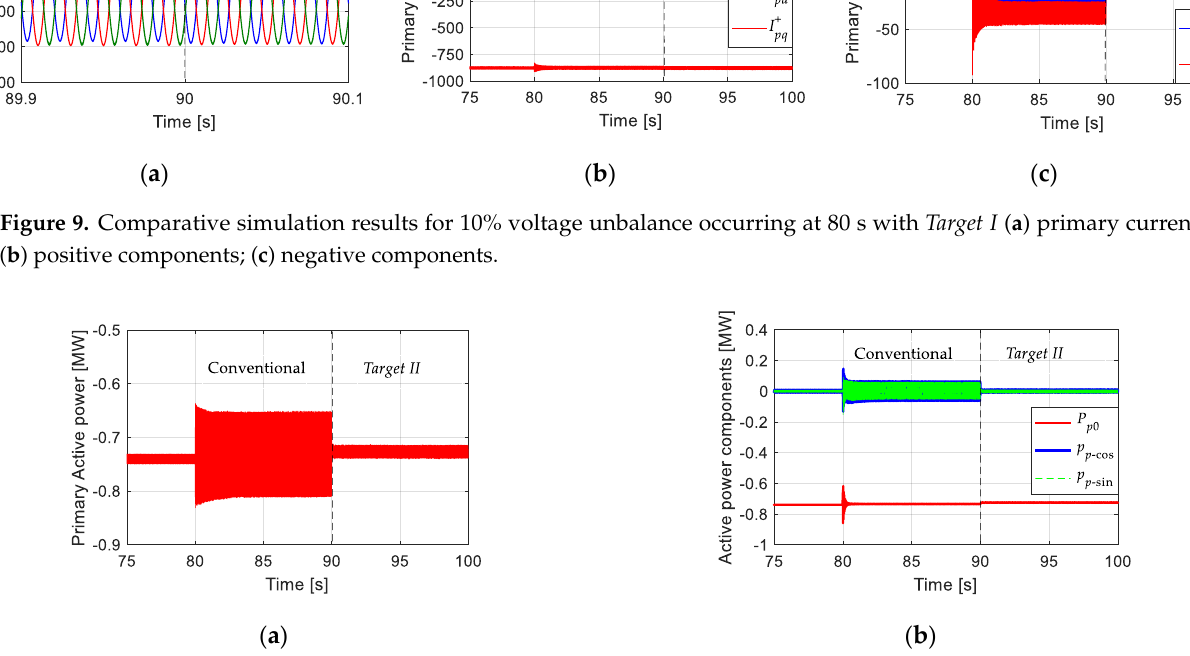
Figure 9. Comparative simulation results for 10% voltage unbalance occurring at 80 s with Target I ( a ) primary current; ( b ) positive components; ( c ) negative components.